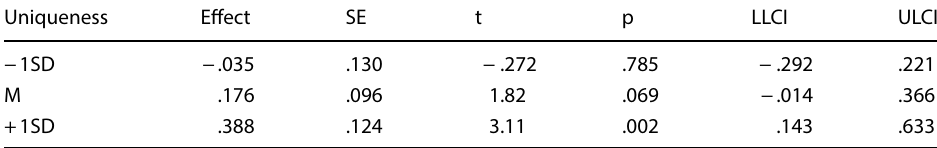
Table 4 Effects of narcissism at values of